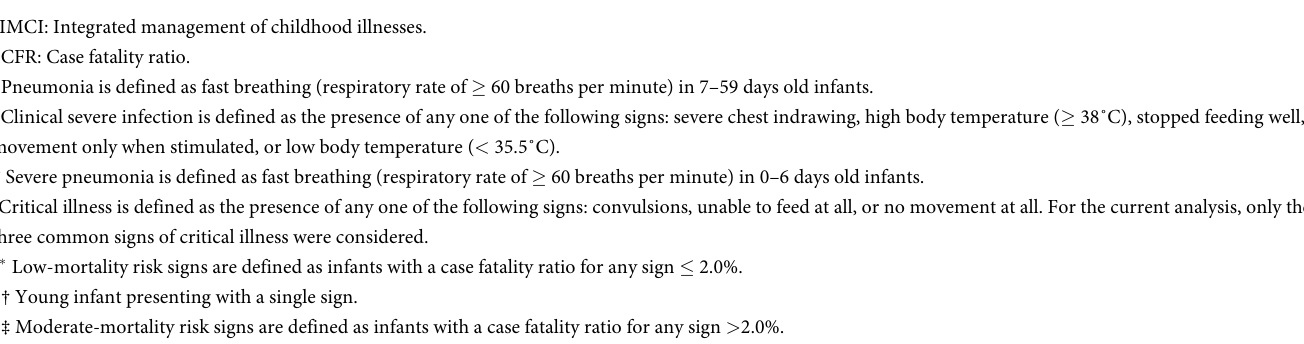
S1 Table. Case fatality ratio (CFR) with the place of treatment by study site and by IMCI � classification and recategorisation of signs of clinical severe infection or severe pneumonia